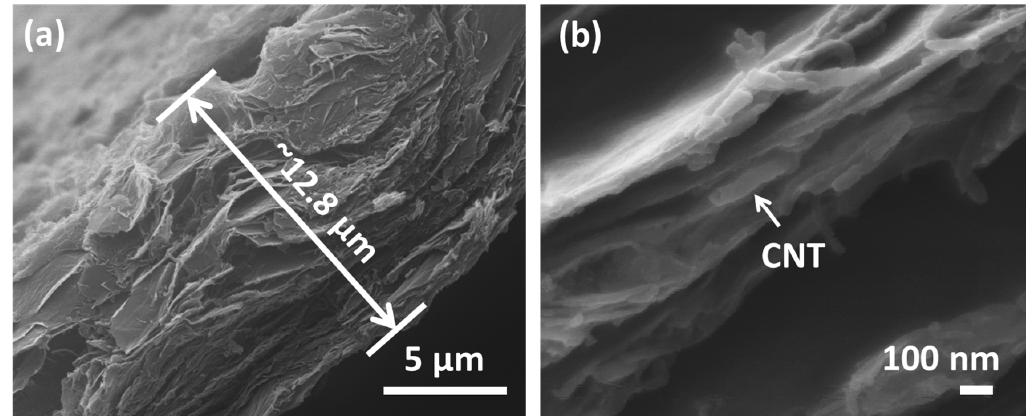
Figure 3. ( a ) and ( b ) SEM images of free-standing rGO/CNT paper cross-sectional views in different Figure 3. ( a , b ) SEM images of free-standing rGO / CNT paper cross-sectional views in magnification. di ff erent